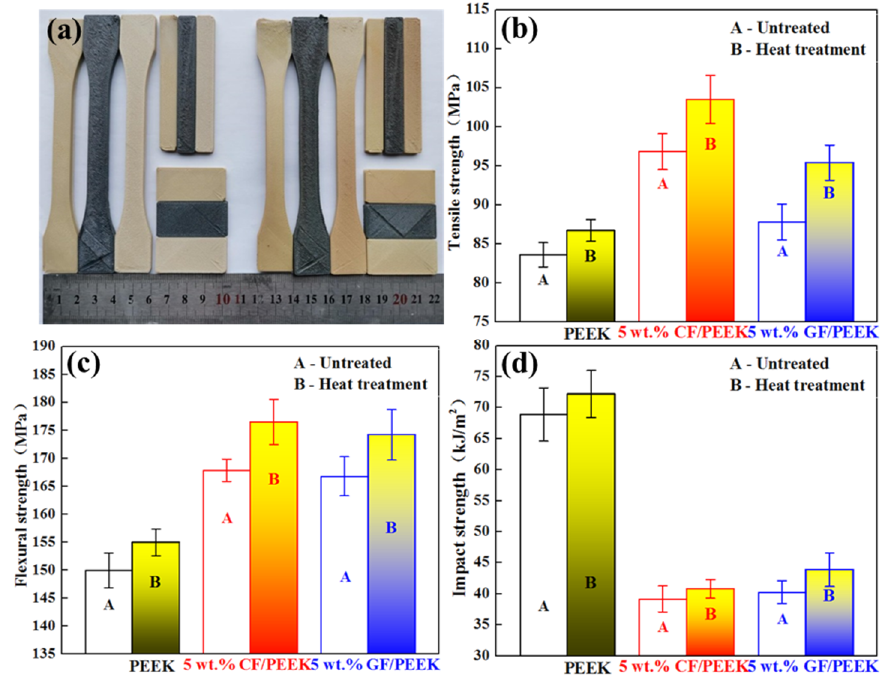
Figure 9. Mechanical properties of FDM 3D-printed PEEK, CF/PEEK and GF/PEEK before and after heat treatment process of 250 ◦ C for 6 h: ( a ) samples before and after heat treatment process; ( b ) tensile strength; ( c ) flexural strength; ( d ) impact